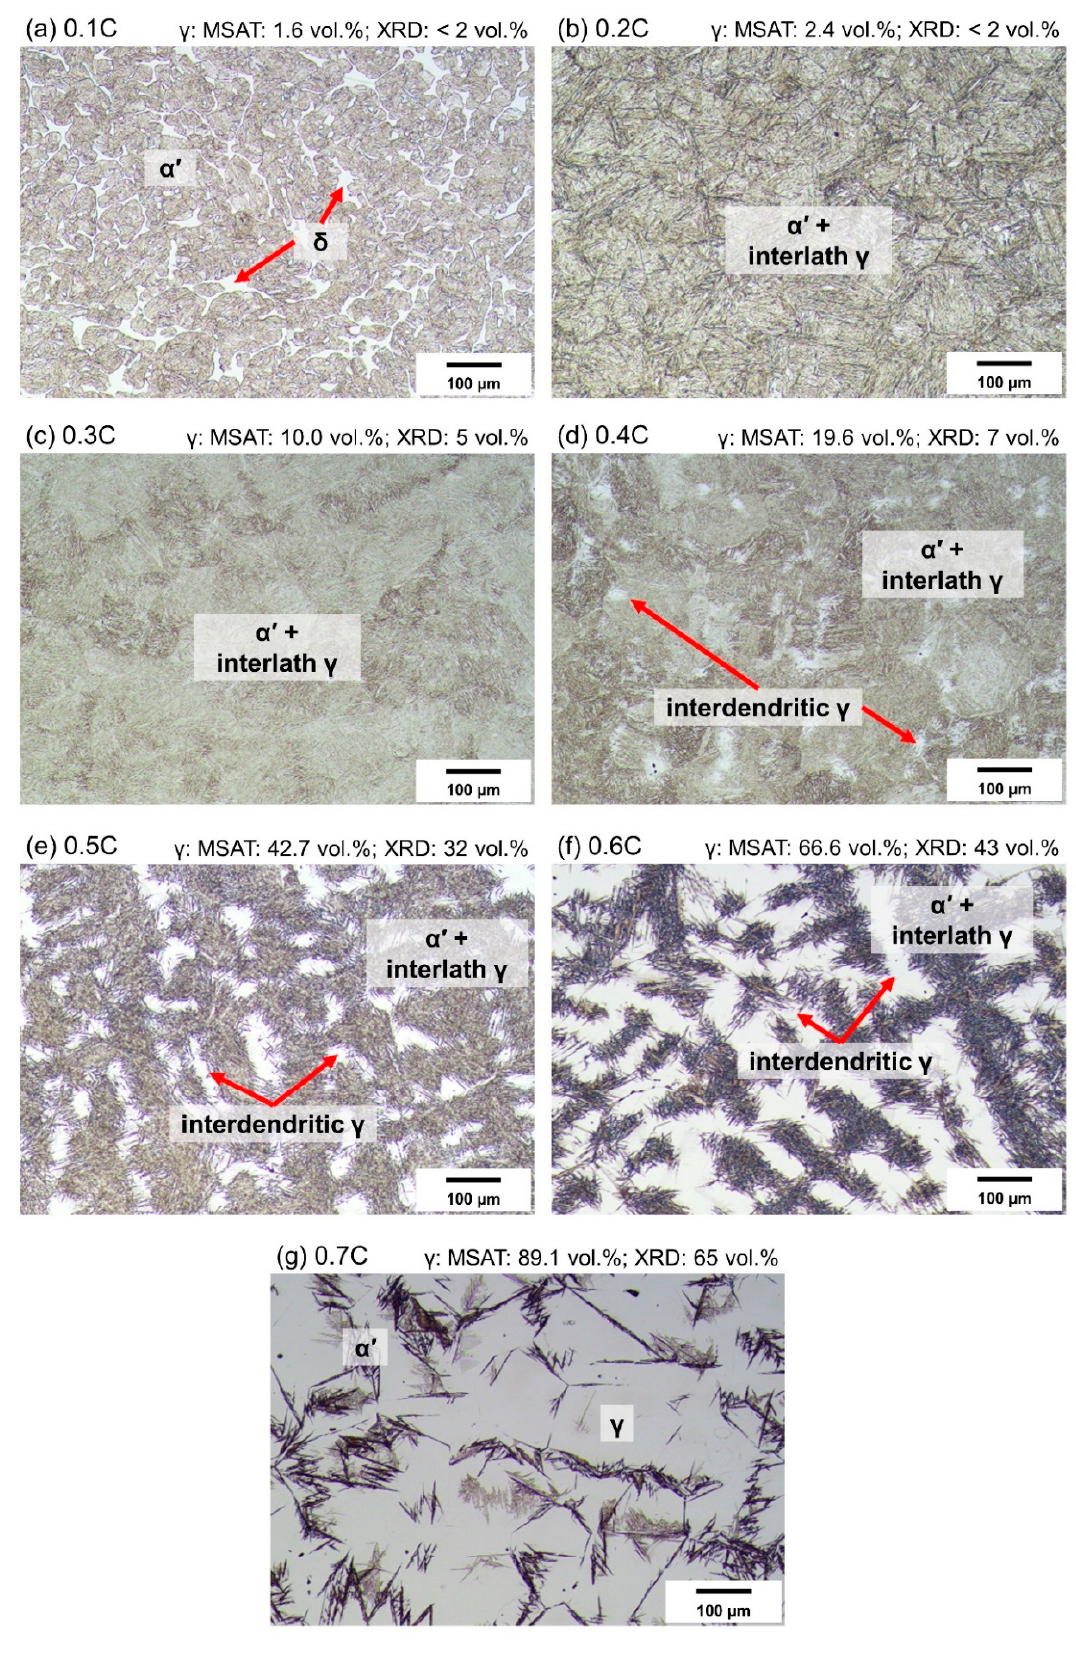
Figure 7. ( a – g ) Optical micrographs of 0.1C–0.7C alloys quenched to RT and etched with Beraha I solution. Numbers above optical micrographs denote phase fractions based on magnetic (MSAT) and XRD measurements, respectively.